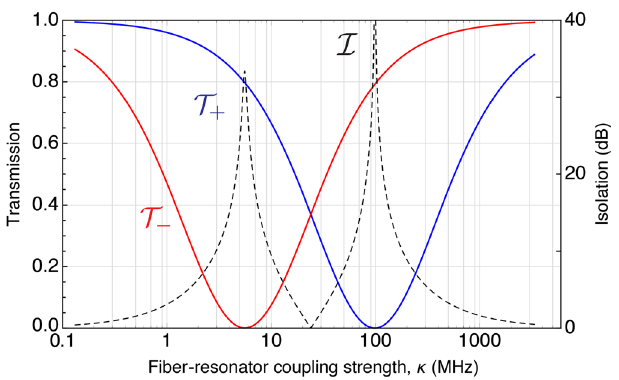
FIG. 4. Calculated nonreciprocal transmission of chiral photons that interact with a single spin-polarized resonator-enhanced atom. The transmission through the nanofiber in ðþ z Þ ( T solid line) and ð − z Þ directions ( T − , red solid line) and the isolation ( I , black dashed line) are plotted as a function of the fiber-resonator coupling strength κ . A magnetic field of B ¼ 4 . 5 G is assumed to be applied along the resonator